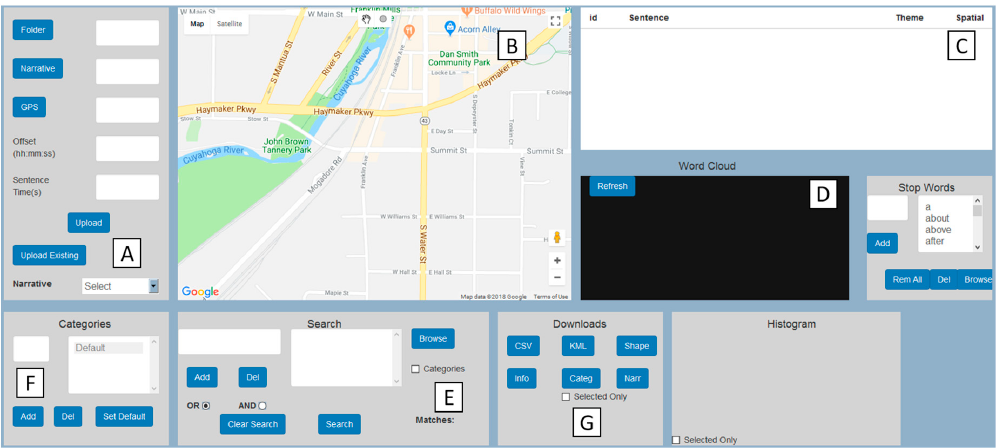
Figure 4. Wordmapper interface diagram ( A ) Input module ( B ) Map in visualization module ( C ) Figure 4 . Wordmapper interface diagram (A) Input module (B) Map in visualization module (C) Narrative sentence table ( D ) Wordcloud in visualization module ( E ) Query module ( F ) Category Narrative sentence table (D) Wordcloud in visualization module (E) Query module (F) Category module ( G ) Output module (G) Output module